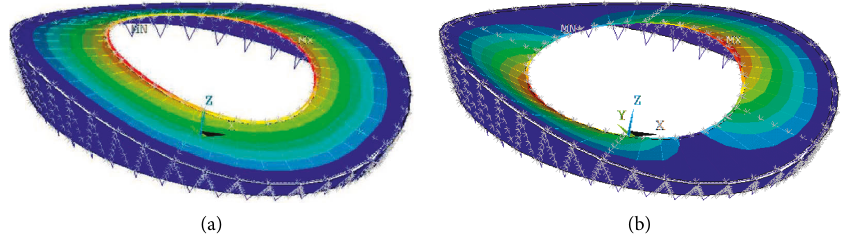
Figure 8: Main vibration modes of the roof. (a) The first mode (0.429 Hz) and (b) the second mode (0.463